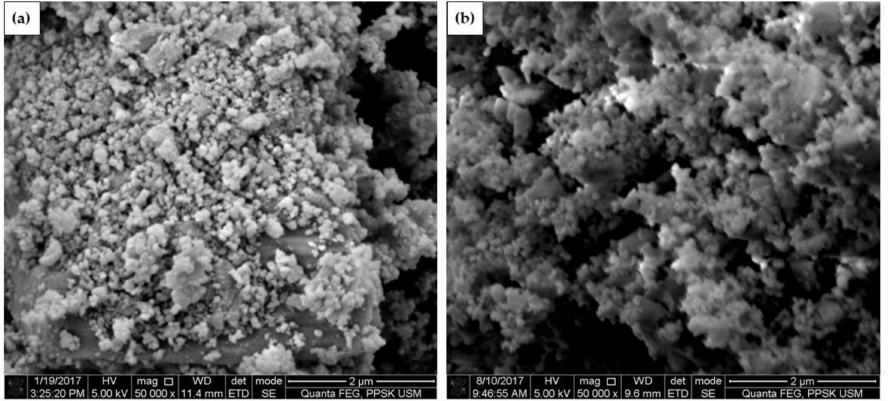
Figure 12. FESEM images of CaO: ( a ) derived from cockle shell; ( b )